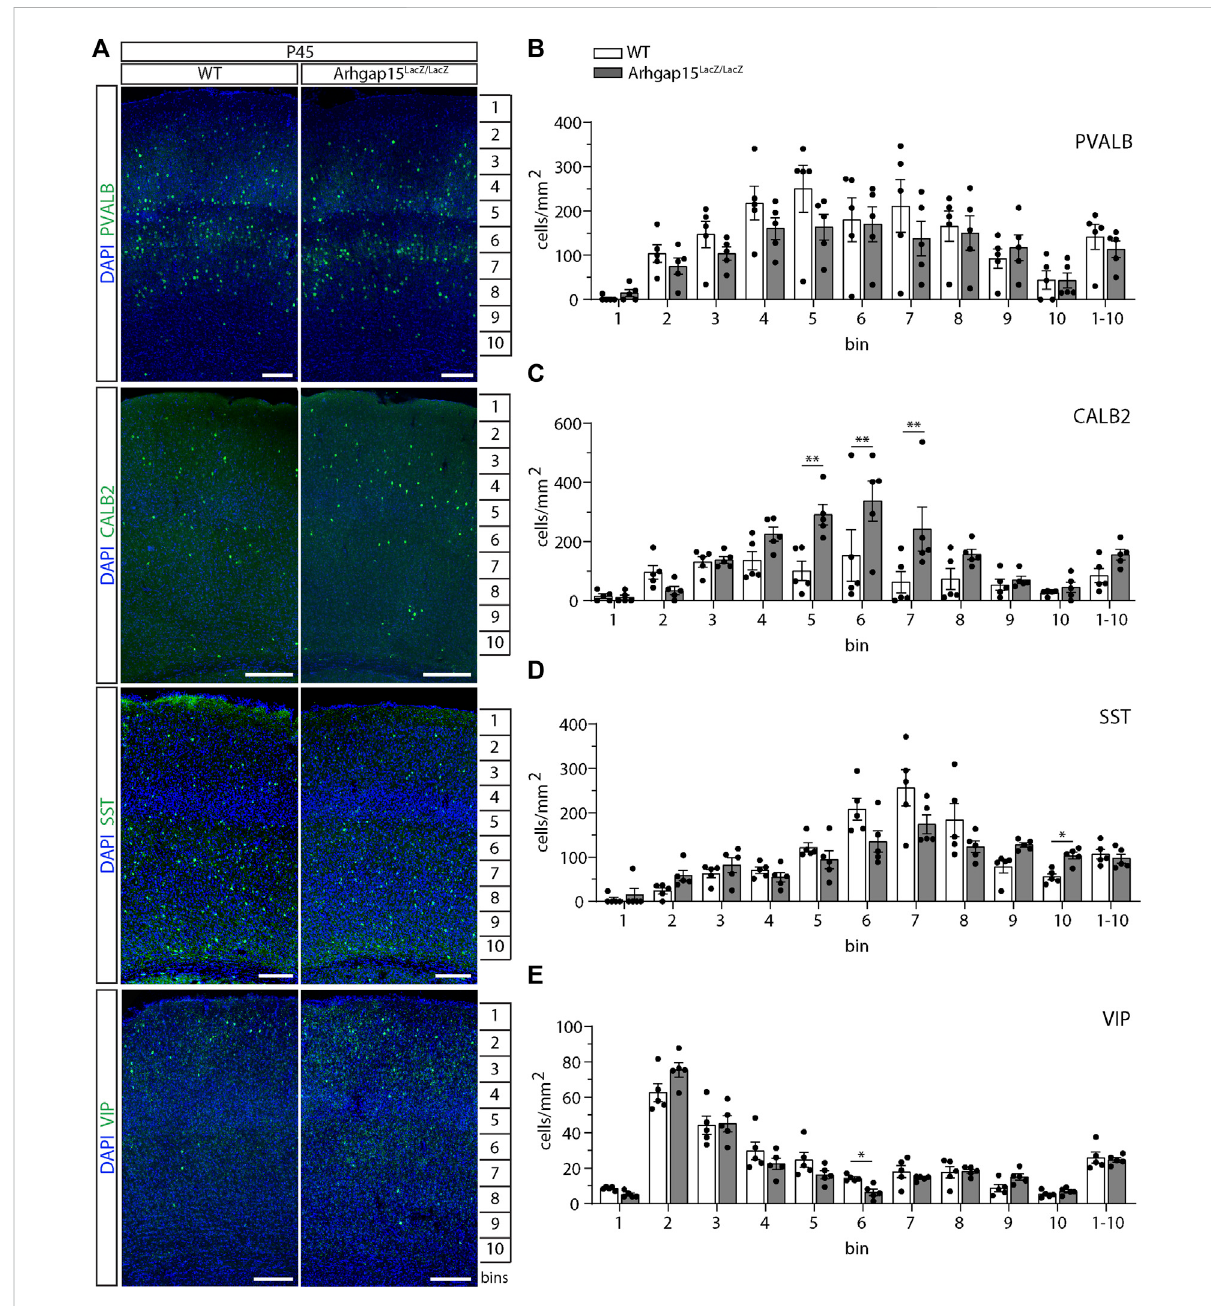
FIGURE 6 CINdistributionacrosslayersintheadultcortex. (A) Maximumintensityprojectionsofz-stackimages(10serialimageplanes;zstepsize=2 μ m) of coronal sections of WT and Arhgap15 LacZ/LacZ P45 somatosensory cortices immunostained for PVALB, CALB2, SST, and VIP. (B – E) Average density of PVALB- (B) , CALB2- (C) , SST- (D) , and VIP- (E) positive neurons in each bin of P45 WT and Arhgap15 LacZ/LacZ somatosensory cortices. At least 4 sections from 5 different mice were analyzed for each genotype. p (PVALB) > 0.99 for all bins; p(CALB2, from bin 1 to 1-10) = 0.99, 0.71, 0.99, 0.47,0.003,0.004,0.005,0.52,0.99,0.99,0.65;p(SST,frombin1to1-10)=0.78,0.32,0.78,0.78,0.78,0.44,0.60,0.72,0.18,0.02,0.78;p(VIP,from bin 1 to 1-10) = 0.07, 0.51, 0.99, 0.76, 0.59, 0.03, 0.77, 0.99, 0.33, 0.72, 0.98. Data are presented as mean ± SEM. p -values were calculated using unpaired multiple t -test corrected for multiple comparisons using the Holm-Sidak method. * = p < 0.05; ** = p <